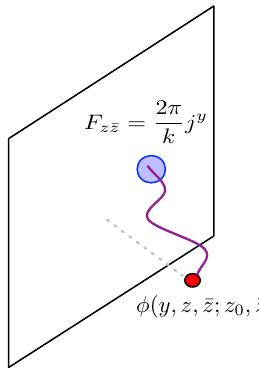
Figure 2 . This (cid:12)gure indicates the relationship between singularities in the current J ( z ), the bulk equations of motion, and Wilson lines. Analogous statements hold for gravity and connect singularities in T ( z ) to the gravitational